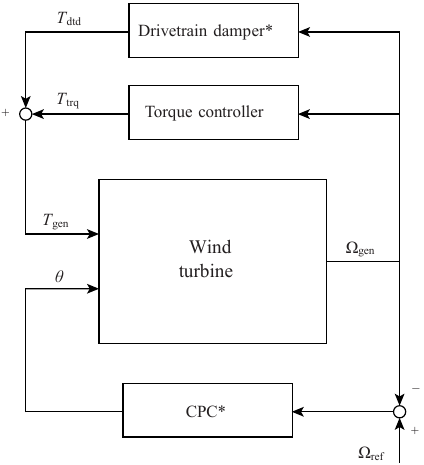
Figure 6. Overview of the relevant controller configuration in this study. The starred controllers will be the subject for